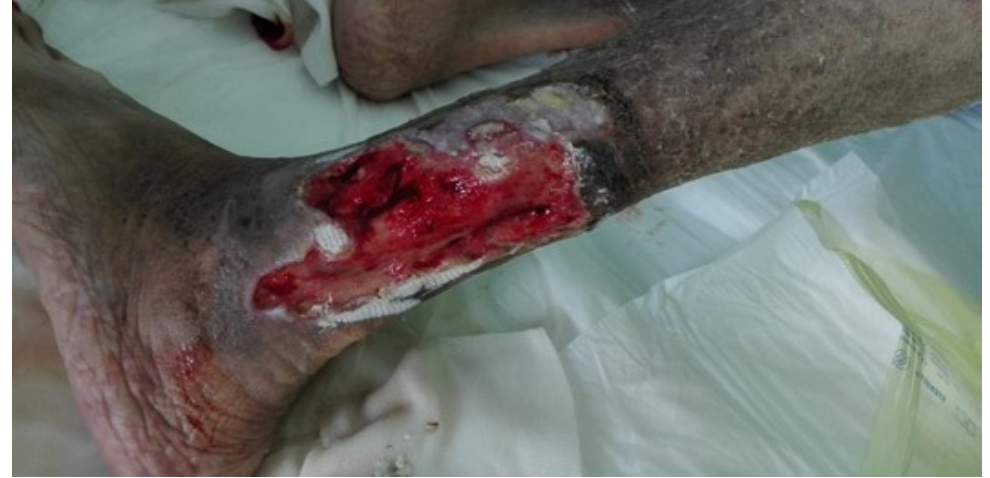
Figure 3. Deep leg ulcer.